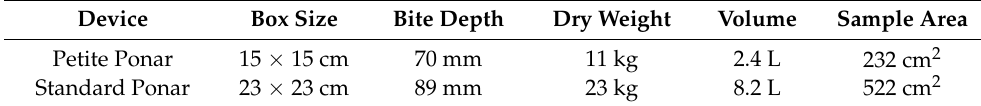
Table 1. Comparative dimensions and “bite depth” of Petite and Standard Ponar devices. Device Box Size Bite Depth Dry Weight Volume Sample Area Petite Ponar 15 × 15 cm Standard